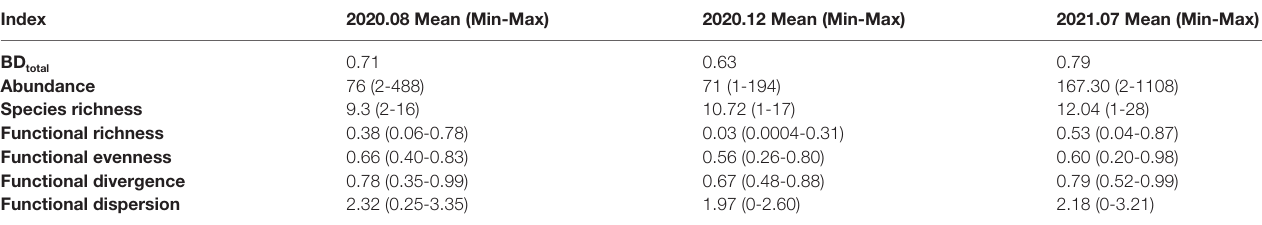
TABLE 1 | The species diversity and the functional diversity indices of the demersal fish community in the PRE.